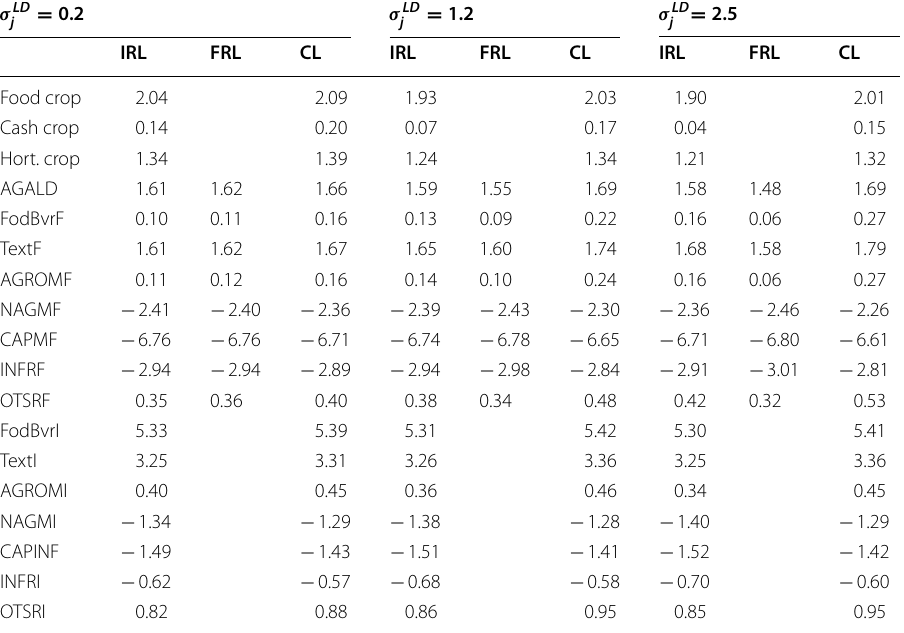
Table 3 Change (%) in labour demand across sectors due to 50% tariff reduction (segmented labour market-1) = 0.2 σ LD j